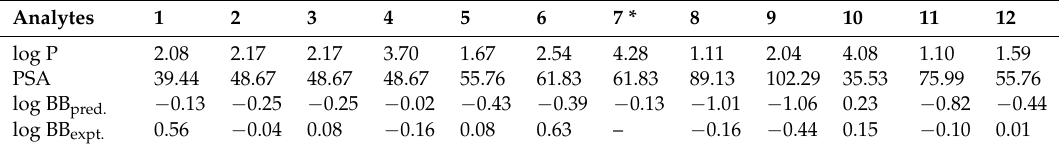
Table 4. The log P, polar surface area (PSA) and log BB (brain, blood) values of the twelve analytes.